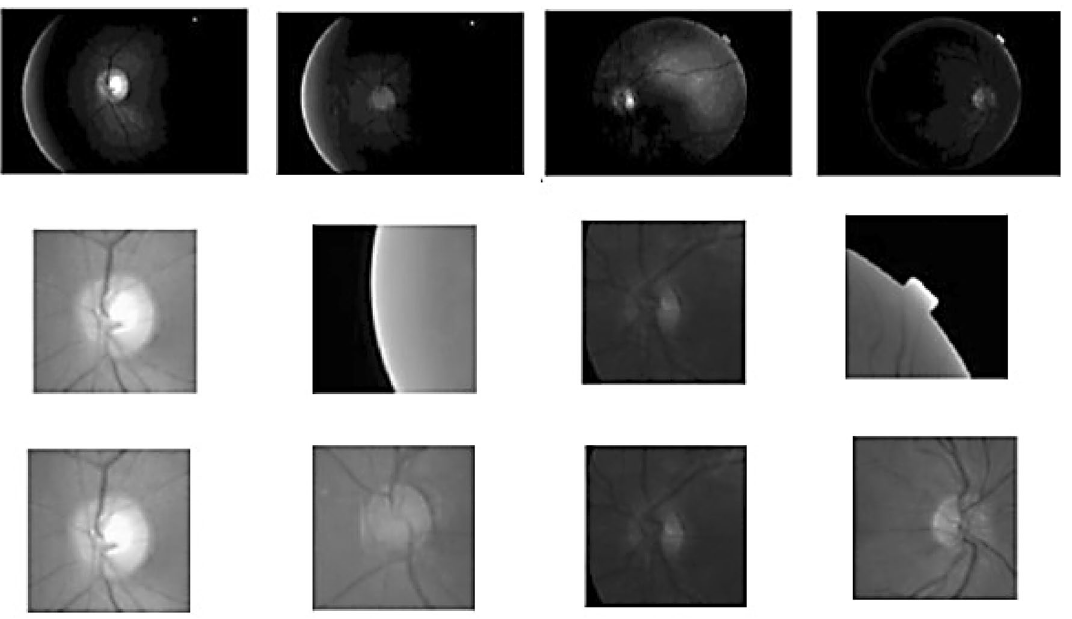
Fig. 3 Visual analysis of OD localization based on the saliency map and saliency map incorporated with shallow CNN. The second row speci- fies the saliency map based OD localization, while the saliency map inbuilt with CNN is used for OD localization in the third row Fig. 3 indicates the OD localization based on a saliency map incorporated with shallow CNN.